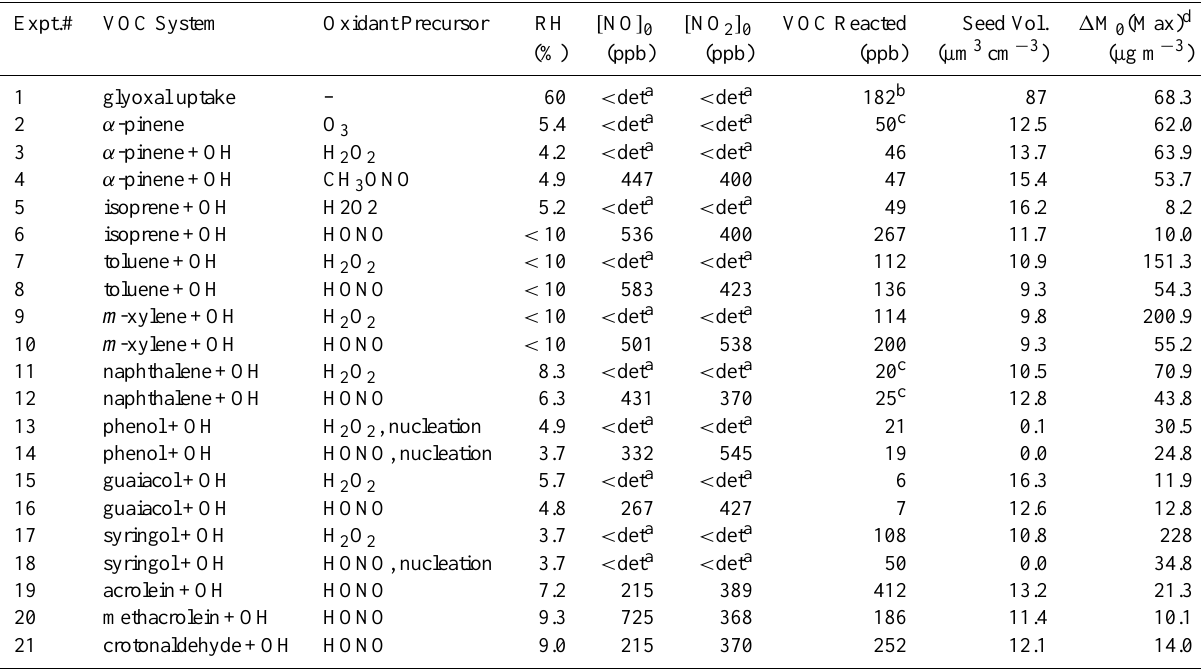
Table 1. Experimental conditions and